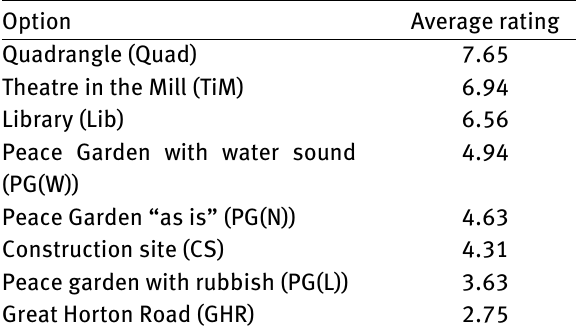
Table 2: Average scores made outdoors for each environmental condition